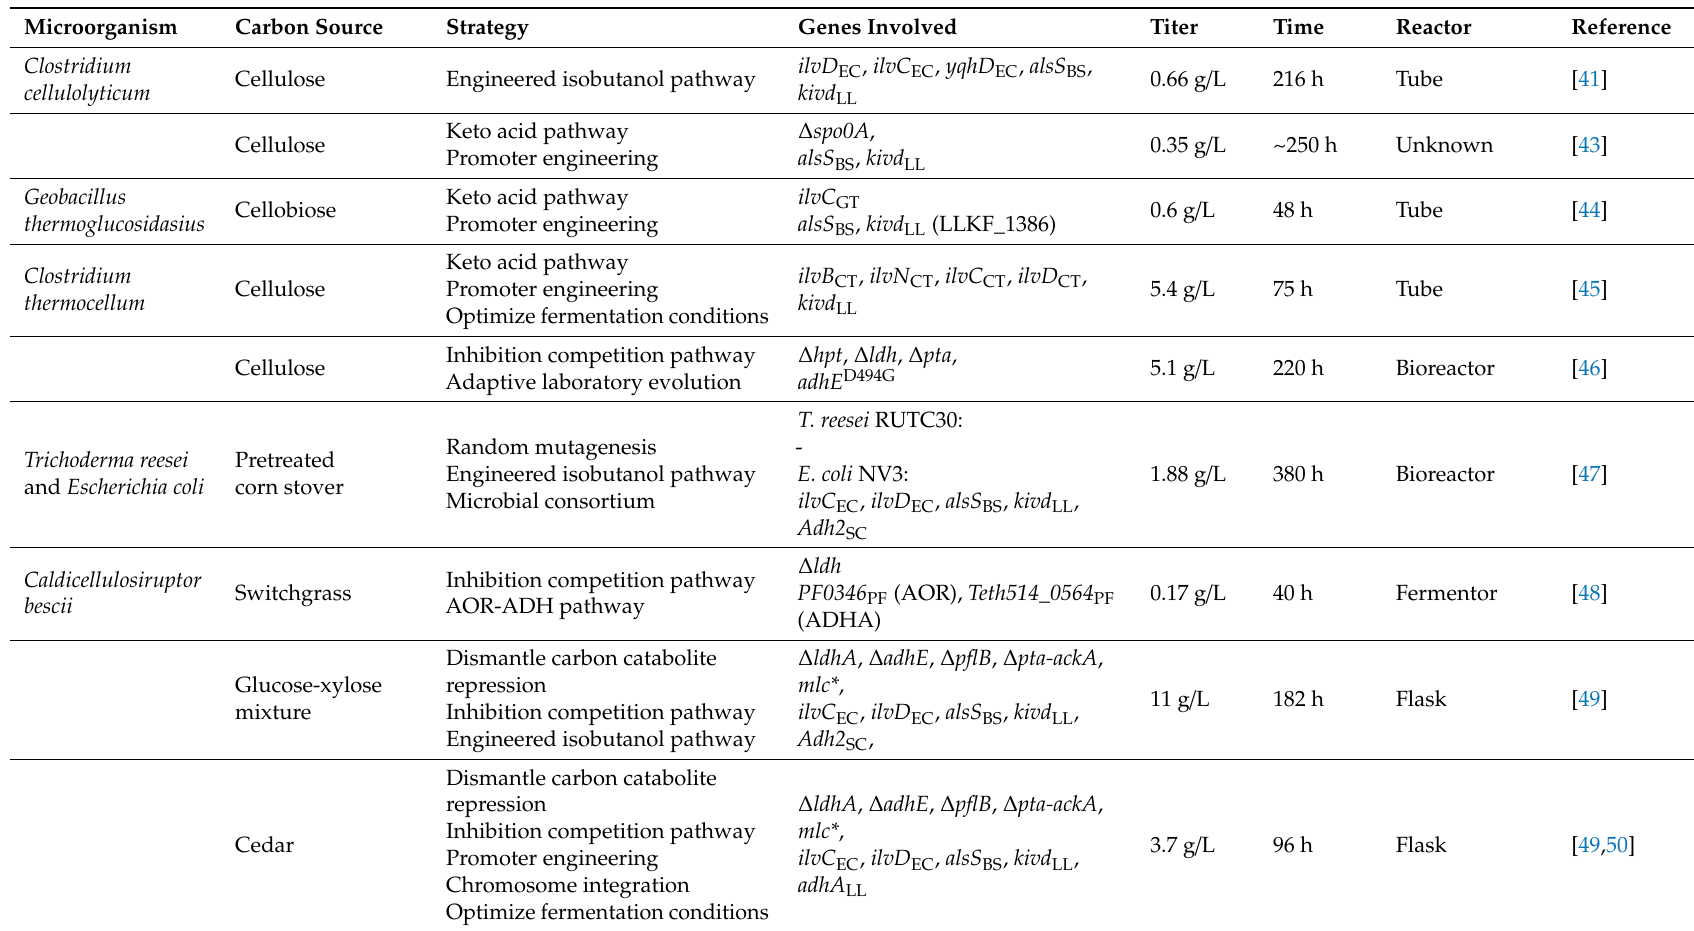
Table 2. Summary of microbial utilization of biomass to produce